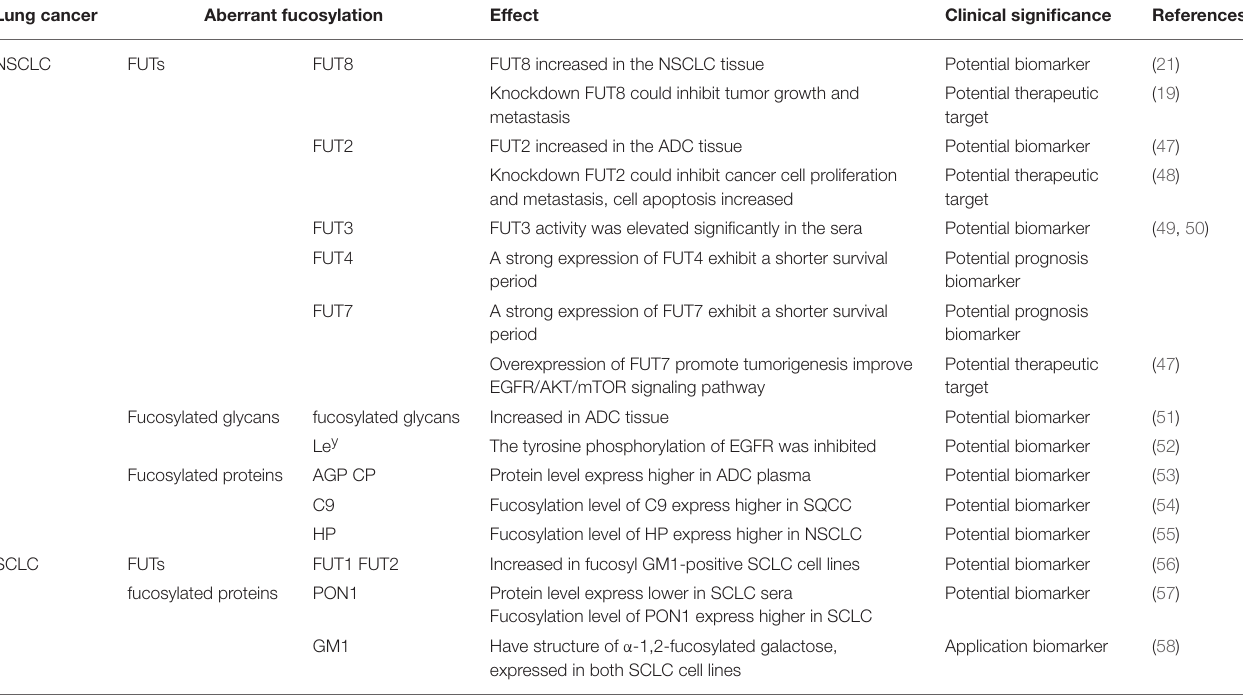
TABLE 1 | Overview of aberrant fucosylation in lung